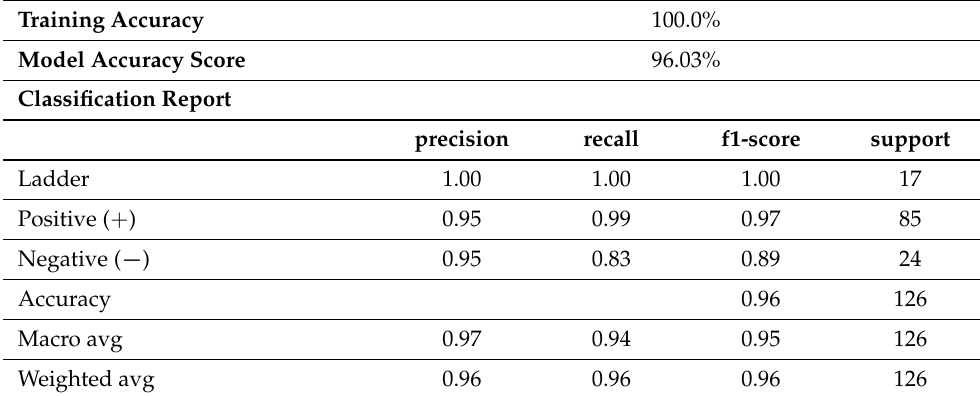
Figure 20. Comparison of the accuracy levels of the different trained classification models. Table 4. Parameters obtained from the training of the XGBoost